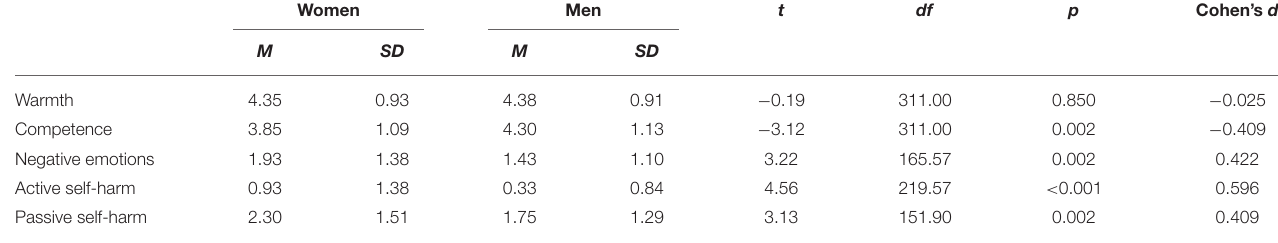
TABLE 4 | Differences between women ( n = 235) and men ( n = 78) on stereotypes, prejudice, and discrimination (subsample A, n = 320). Women